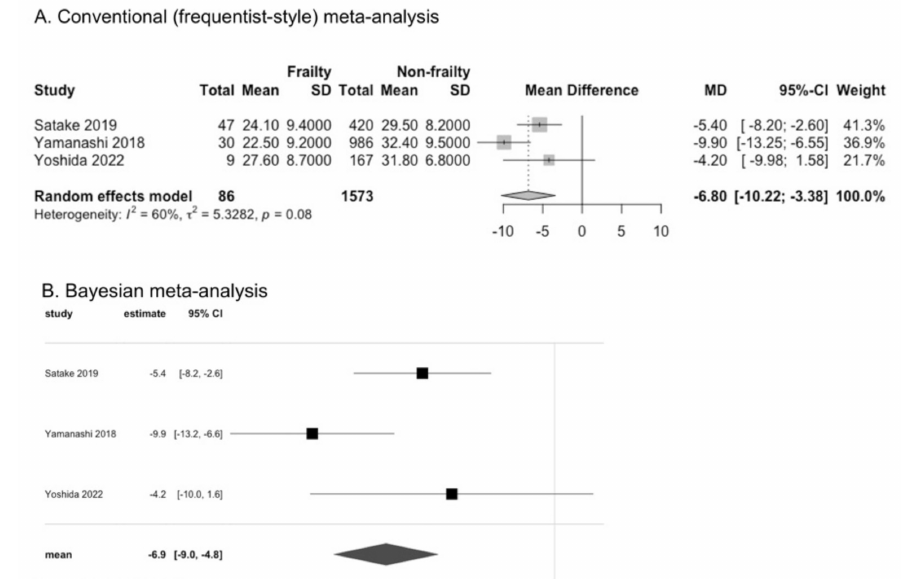
Figure 1. Comparison of tongue pressure between individuals with and without frailty